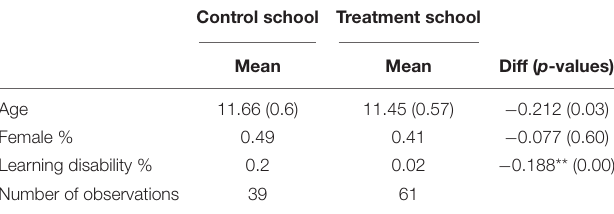
TABLE 2 | Descriptive statistics at baseline, Ireland